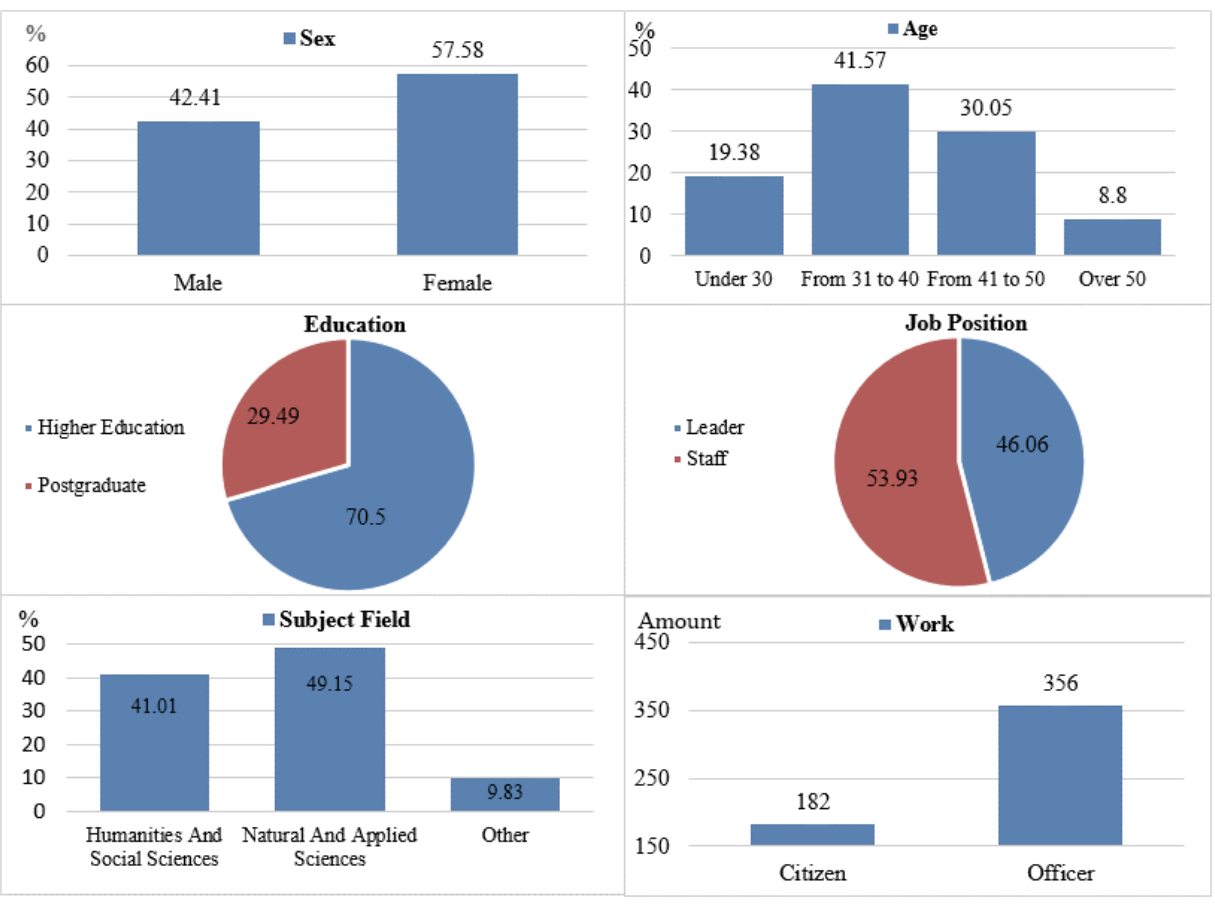
Figure 2. Sample Demographics